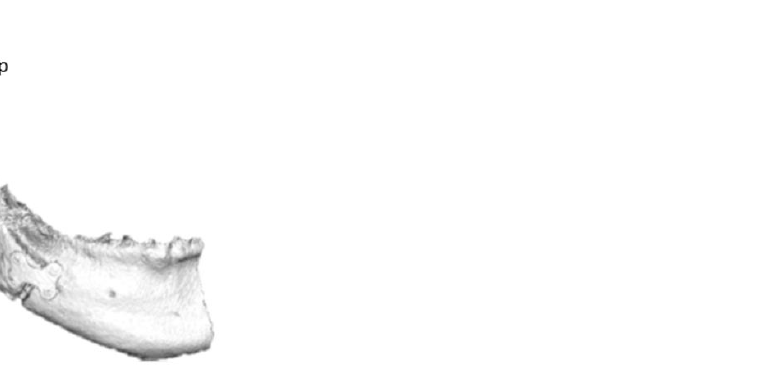
Figure 4. Setting landmarks of proximal bone fragment. Lp: lateral point, Cp: coronoid process, An: antegonial notch.